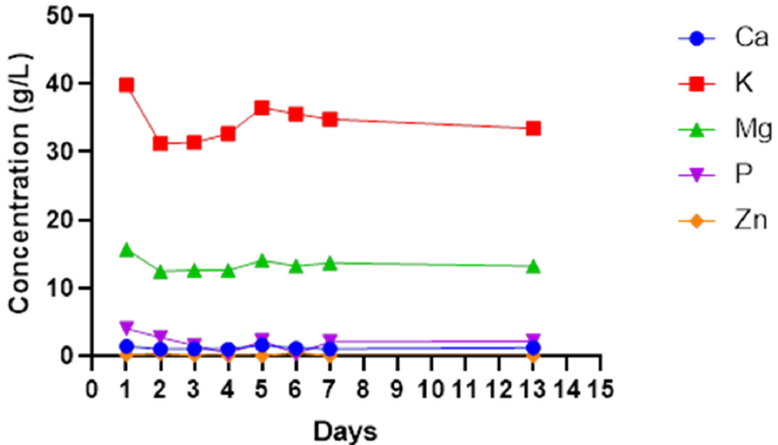
Figure 5. Mineral content of the fermenting wine.